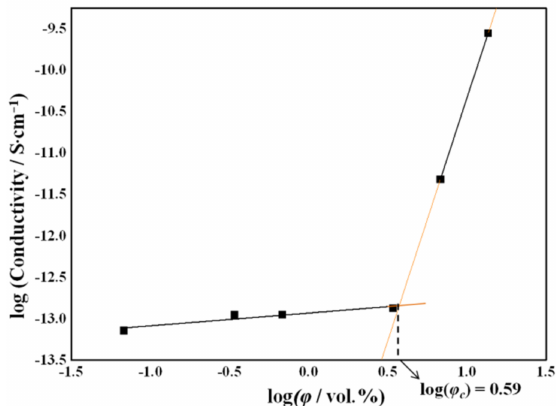
Figure 10. Double logarithmic plot of the conductivity as a function of the filler volume fraction. From the generalizations of the Bruggeman equation and a concept of shape-distributed particle composites, in 2D, the percolation threshold for identical overlapping ellipses with aspect ratio η , whose centers and orientations are random, can be fitted to the formula [65]